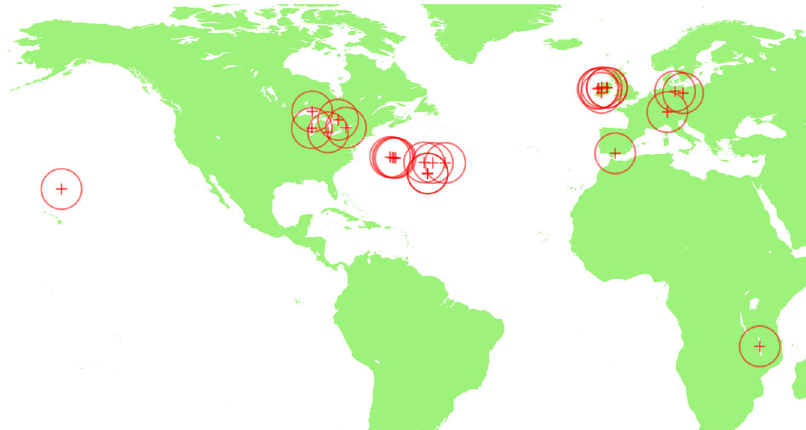
Fig. 5 Locations of study sites included in